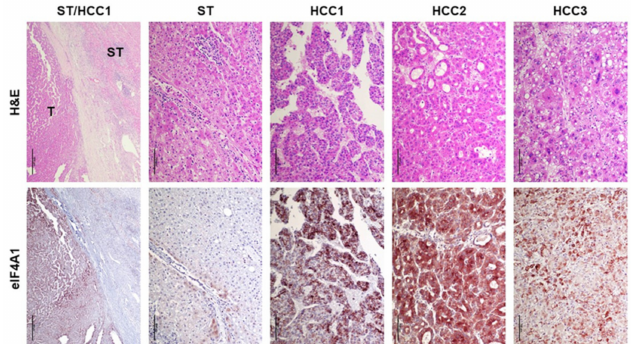
Figure 4. Representative immunohistochemistry patterns of eIF4A1 protein in human hepatocellular carcinoma (HCC; n = 356). The first left panels show an example of human HCC (denominated HCC1) at low magnification. Note the enhanced immunoreactivity for eIF4A1 in the tumorous part (T) compared with the neighboring non-tumorous surrounding tissue (ST), which exhibits faint/absent eIF4A1 staining. The second and third left panels depict higher magnifications for ST and HCC1. A second tumor (HCC2), characterized by intense, homogeneous eIF4A1 immunoreactivity, is shown in the fourth panel from the left. Finally, a third tumor (HCC3) in the right panels displays hetero- geneous eIF4A1 immunolabeling. Abbreviation: H&E, hematoxylin and eosin staining. Original magnifications: 40 × in the first left panels, 200 × in all the other panels. Scale bar: 500 µ m in the first left panels, 100 µ m in all the other